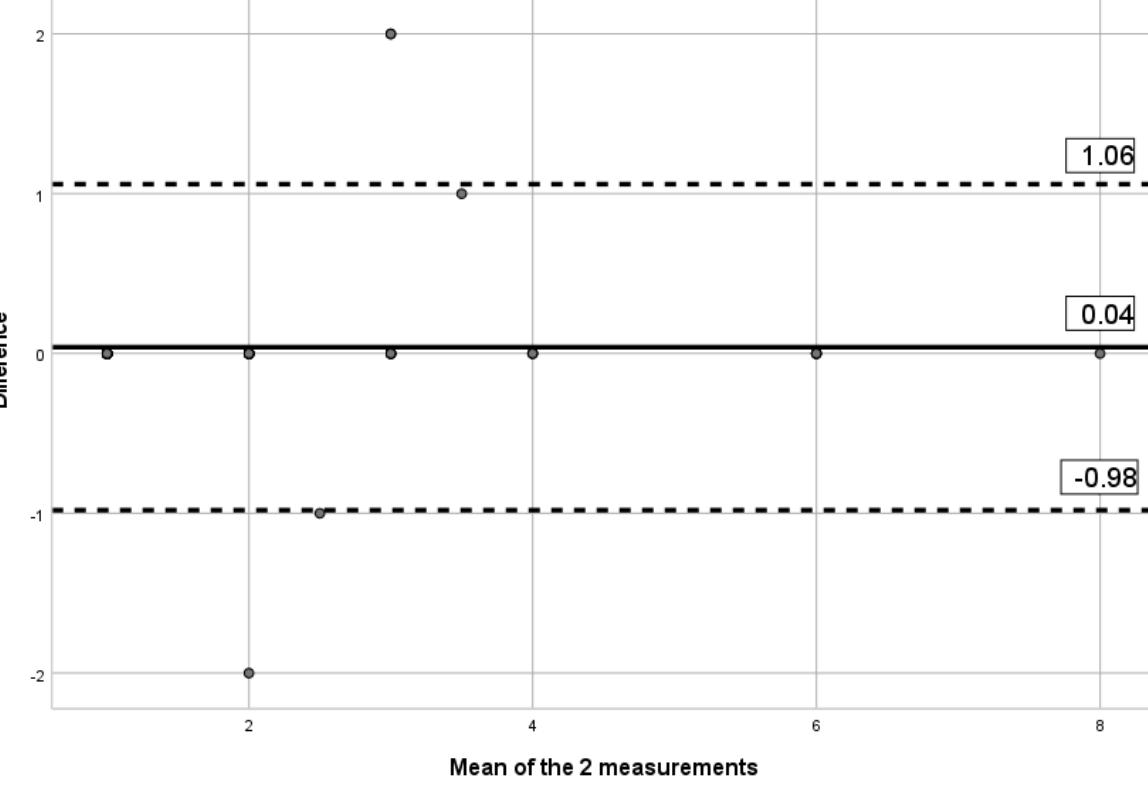
Figure 7. Bland-Altman limits for the number of painful body sites between the 2 assessments using the